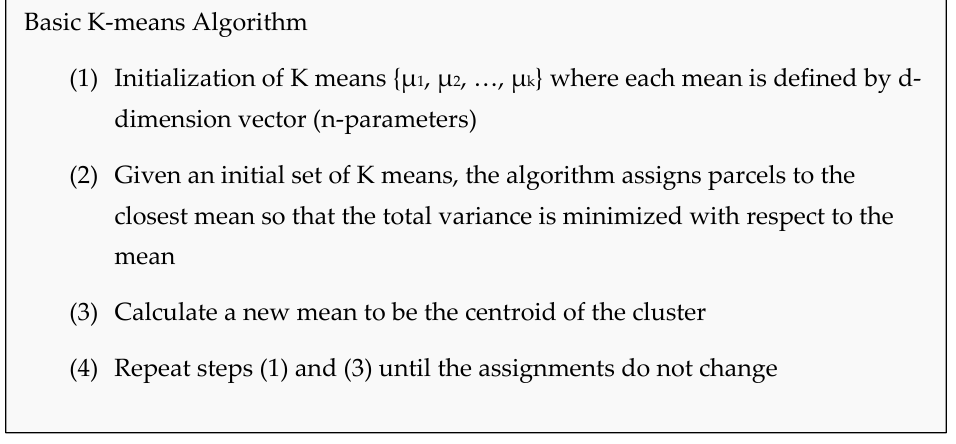
Figure 4. Basic K-means Figure 4. Basic K ‐ means Algorithm.